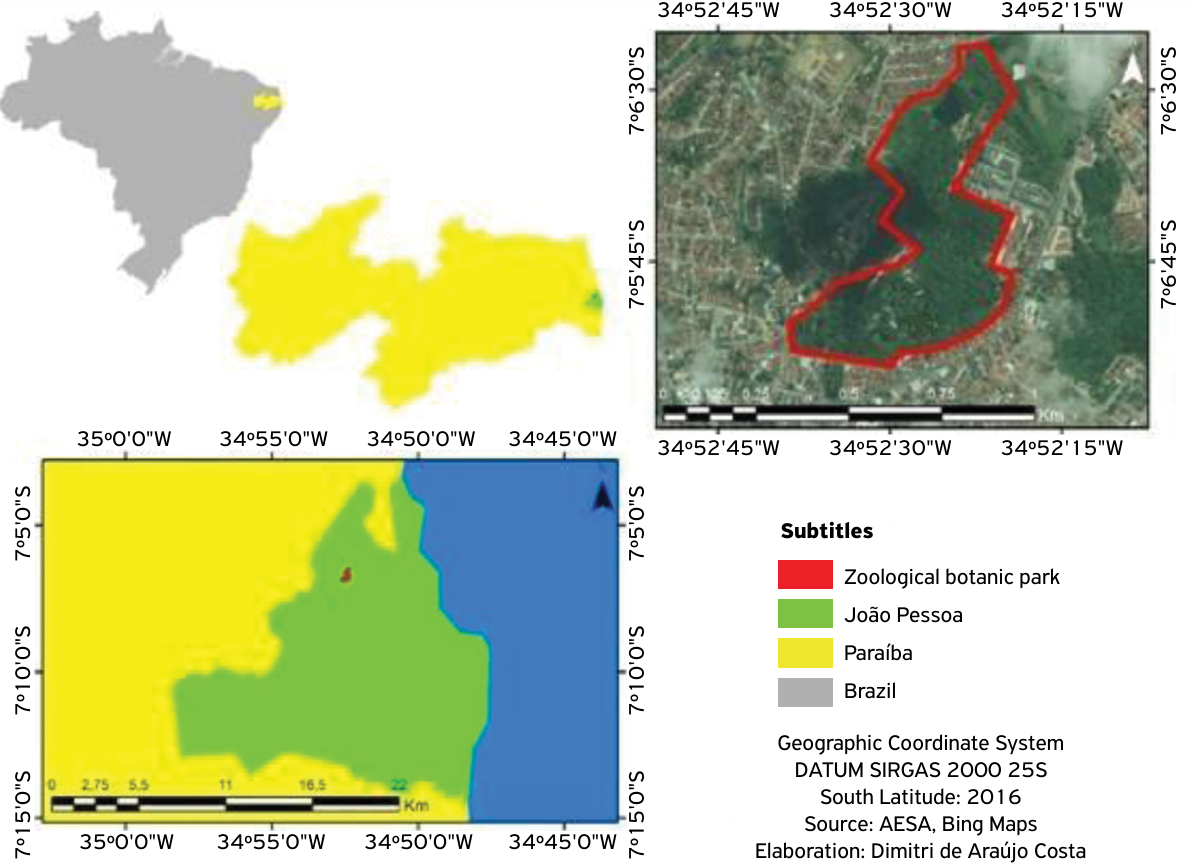
Source: COSTA et al. Figure 1. Map of the Arruda Câmara Zoological-Botanical Park localization, municipality of João Pessoa (PB), Brazil.